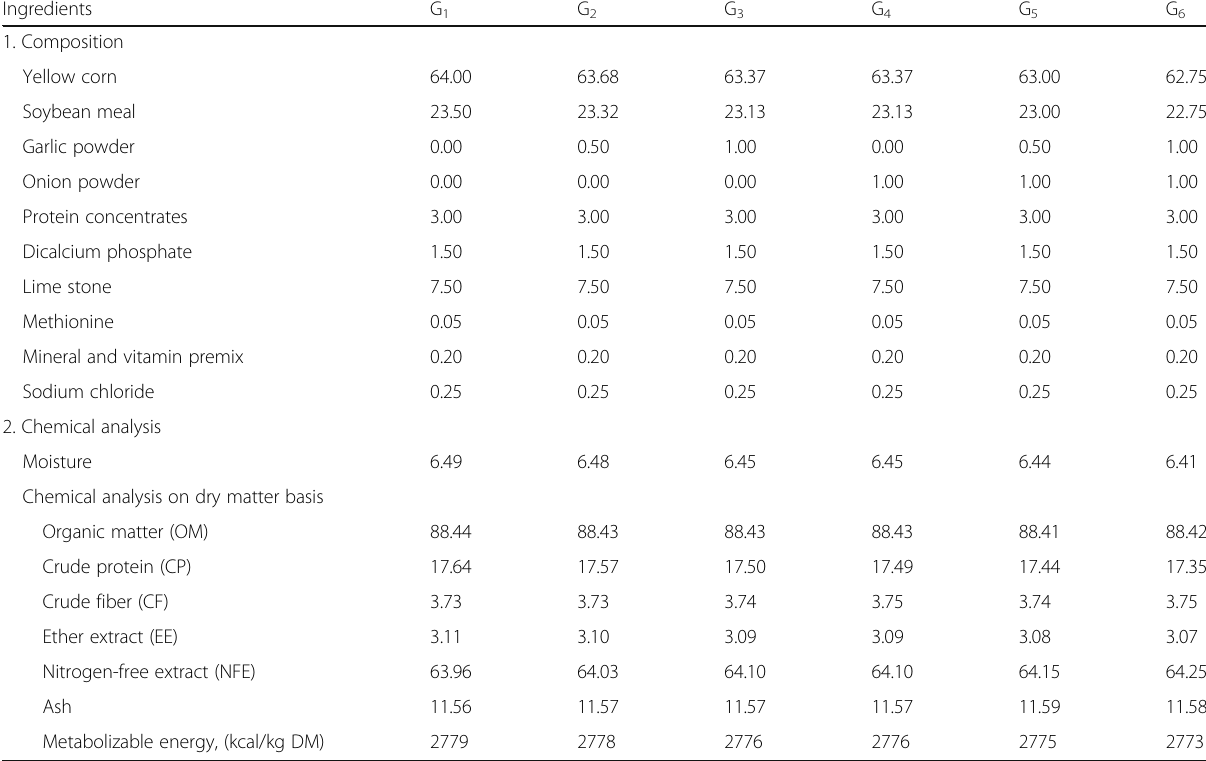
Table 1 Composition and calculated chemical analysis of different experimental rations Ingredients Yellow corn